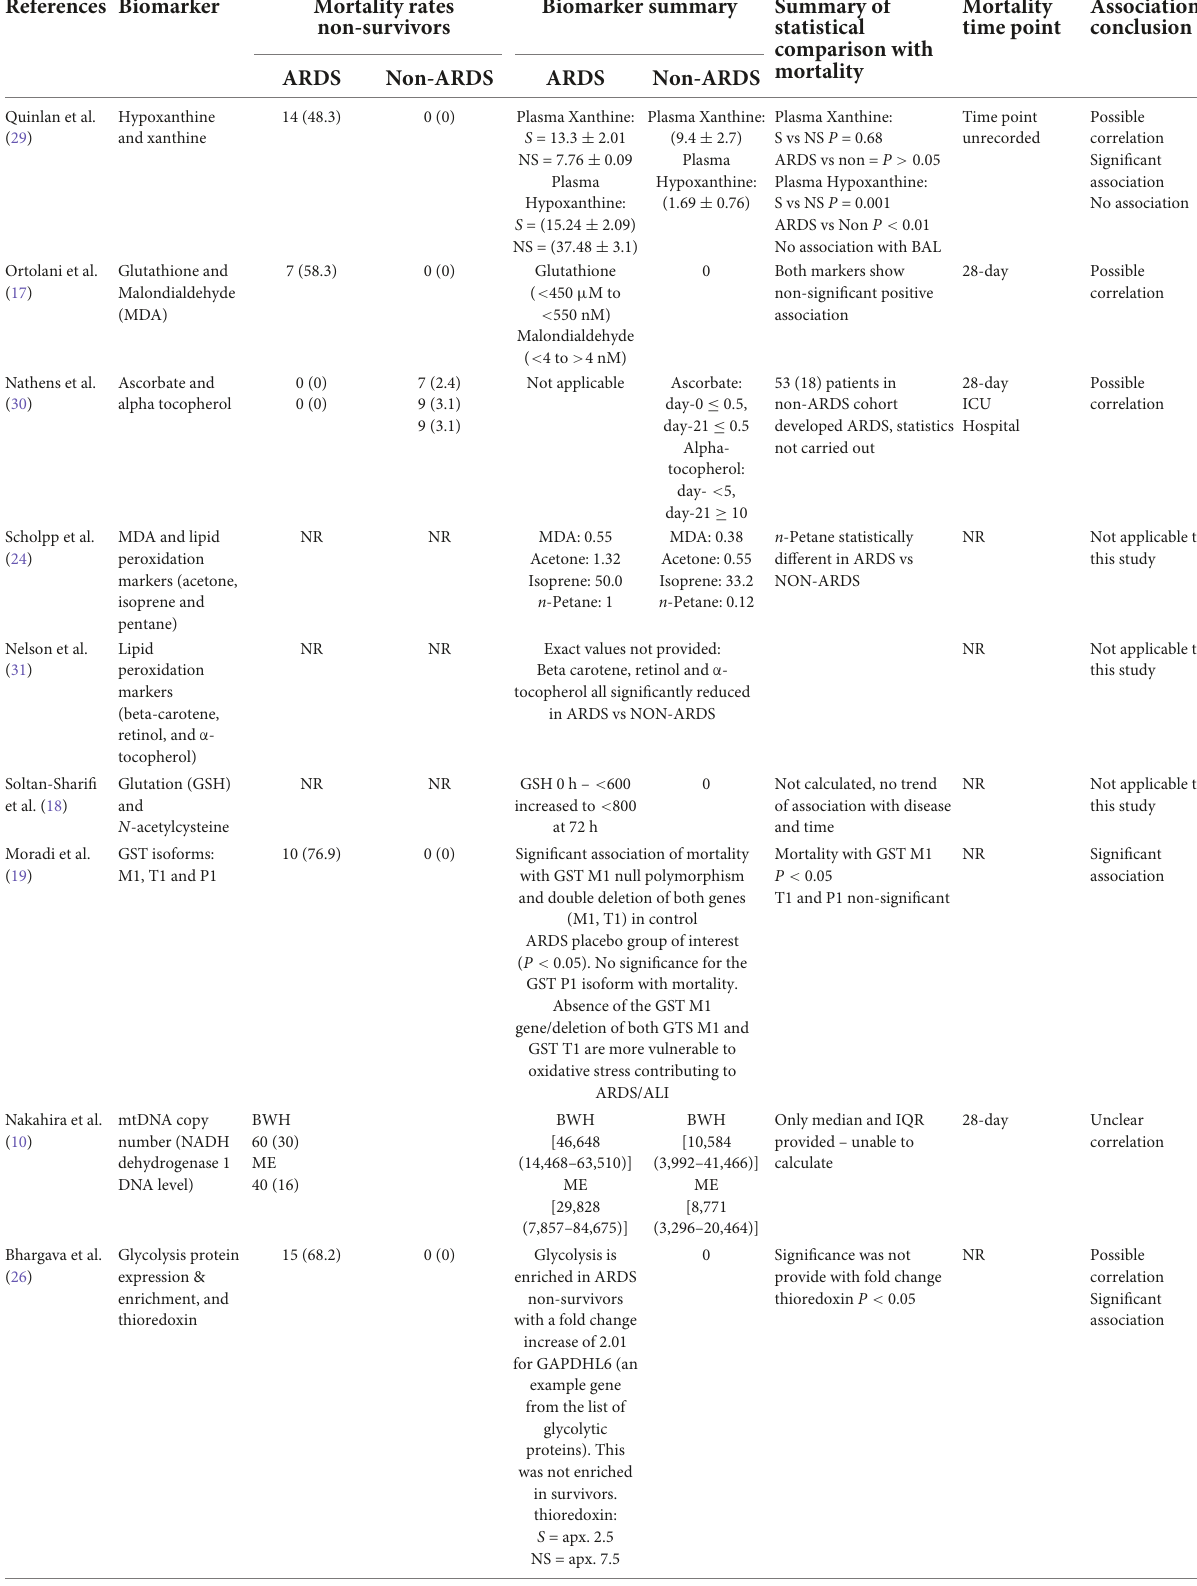
TABLE 4 Primary outcome: Association of mitochondrial biomarker levels with ARDS